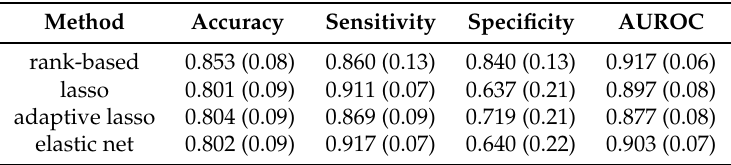
Table 8. Estimated mean values and standard deviations for the four metrics across the four competing penalized logistic regression models computed from 100 resamplings. The values in parentheseses are standard